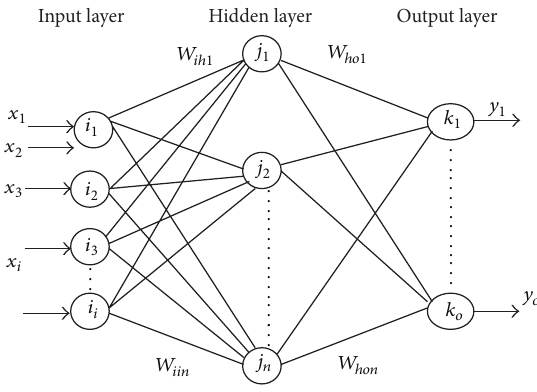
Figure3:ANNtopology: 𝑥𝑖 isthe 𝑥 thinputfeature; 𝑖𝑖 isthe 𝑖 thinput node; 𝑗𝑖 is the 𝑗 th hidden layer; 𝑘𝑖 is the 𝑘 th output layer neuron and 𝑦𝑖 is the 𝑦 th output; 𝑤 𝑖𝑗 is weight between input and hidden layers and 𝑤 ℎ𝑜 is weight between hidden and output